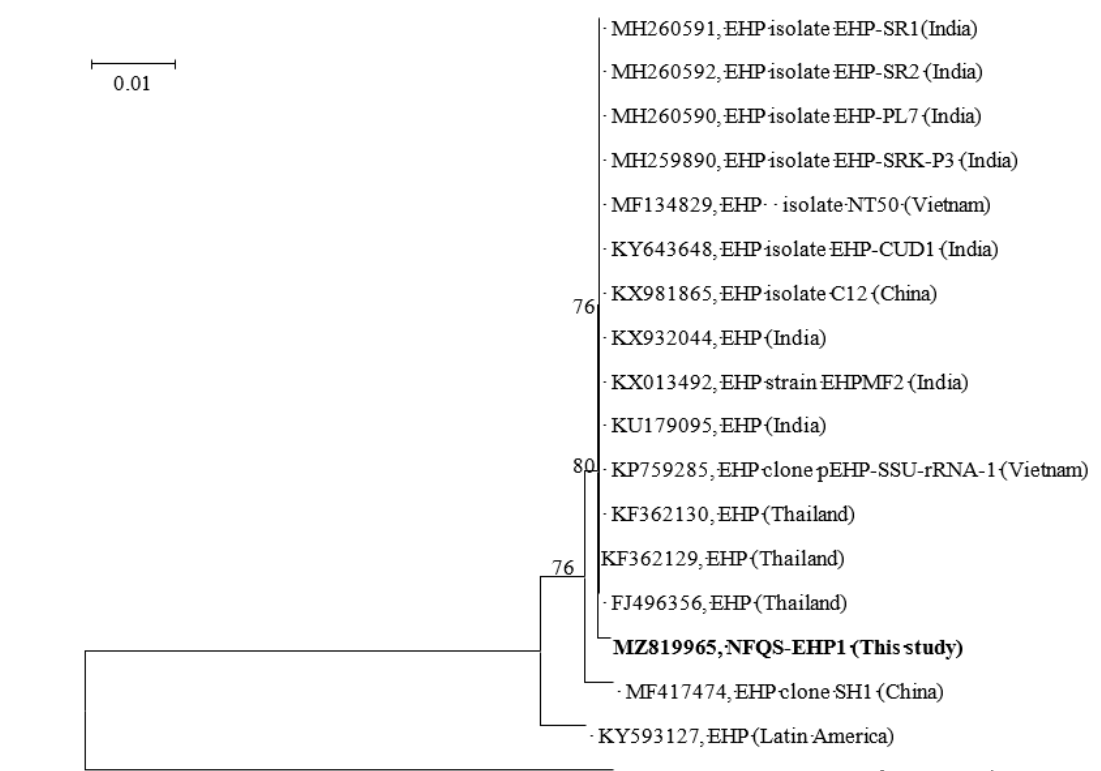
Figure 2. The phylogenetic tree was constructed using the neighbor-joining method, using MEGA software (version X; http://www.megasoftware.net (accessed on 18 August 2021)). All reference sequences were acquired from the GenBank database (http://www.ncbi.nlm.nih.gov/genbank (accessed on 18 August 2021)). Enterocytozoon bieneusi (DQ793212) was used as the outgroup. Only bootstrap values above 70% are shown (1000 resamplings) at branch points. Bar, 0.01 substitutions per site.